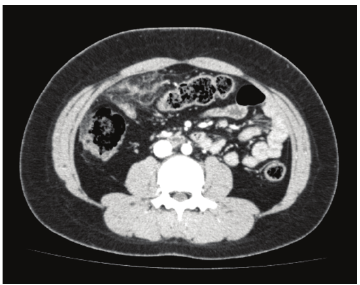
Figure 1: Enhanced CT reveals a 5 × 8 cm ill-defined heterogeneous fatty mass with hyperattenuating streaks just beneath the abdominal wall anterior to the transverse